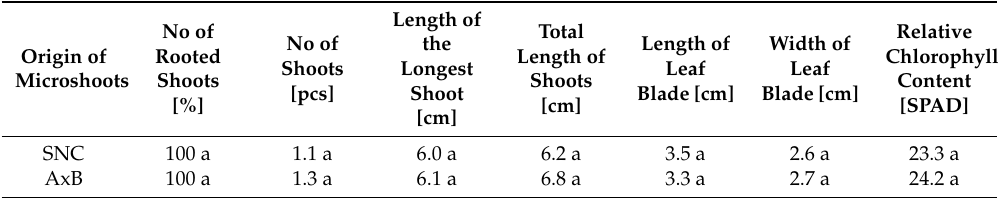
Table 8. Chosen traits of acclimated, four weeks old mountain mulberry ‘Kenmochi’ plantlets of di ff erent origin.